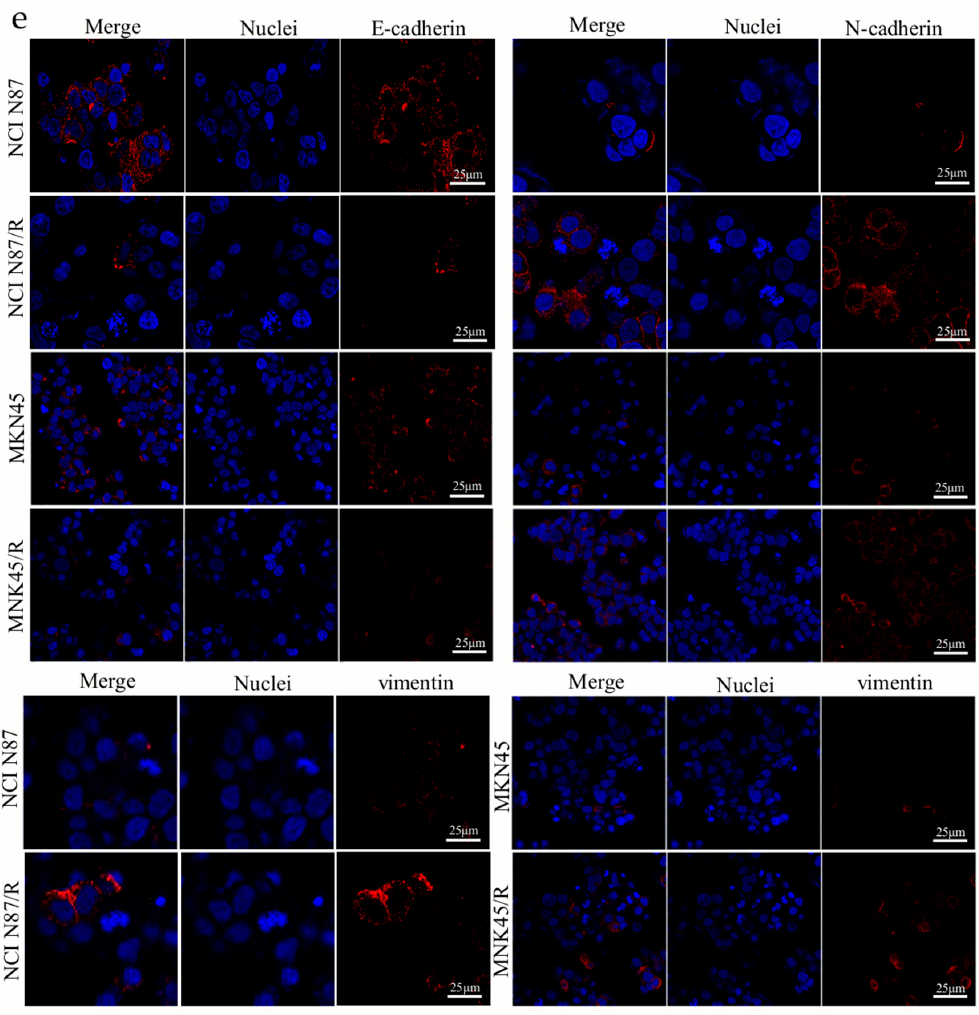
Figure 1. Trastuzumab resistance is associated with epithelial-mesenchymal transition (EMT) in gastric cancer cells. ( a , b ) MKN45/R and NCI N87/R cells showed morphological changes when compared with their parental cells respectively; ( c ) Images of cells stained with antibodies against β -tubulin (red), and nuclei stained with DAPI (blue) (original magnification ×10 for NCI N87 and NCI N87/R cells, ×20 for MKN45 and MKN45/R cells respectively); ( d ) Expression of E-cadherin, N-cadherin, vimentin, snail1, and twist in trastuzumab-resistant cells and their parental cells as detected by western blot; ( e ) NCI N87, NCI N87/R, MKN45, and MKN45/R cells were labeled with antibodies against E-cadherin, N-cadherin, and vimentin. Binding was detected by Alexa Fluor ® 594-labeled secondary antibody. Staining of nuclei was done with 1 μ g/mL DAPI.